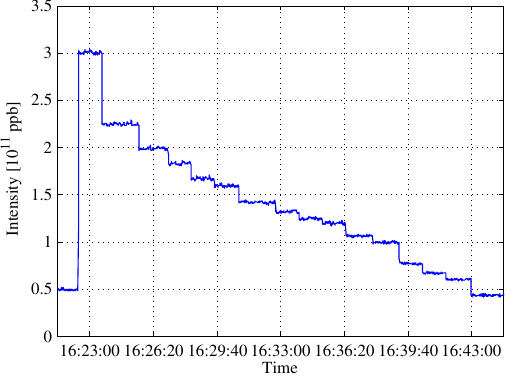
FIG. 7. Scraping of a single bunch during multiturn data acquisition with an ac dipole during the machine fill 3338 on